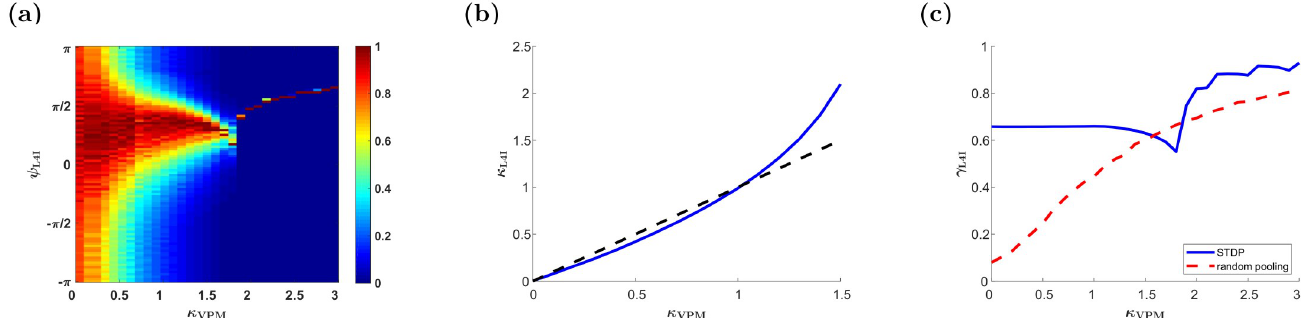
Fig 5. The effect of the distribution width of the upstream population, κ VPM . (a) The (non-normalized) distribution of the preferred phases of L4I neurons, κ L4I , is shown by color as a function of the width of the distribution of preferred phases in VPM, κ VPM . (b) The distribution width in layer 4, κ L4I , is shown as a function of κ VPM (blue). The identity line is shown (dashed black) for comparison. (c) The modulation depth in the downstream population, γ L4I , is shown as a function of κ VPM (blue). For comparison, the modulation depth of the uniform pooling model is also presented (dashed red). The parameters used here are: � n ¼ n = ð 2 p Þ ¼ 7 Hz , κ VPM = 1, γ = 1, D = 10hz, d = 3ms, ϕ 0 = 5 π /6. For the STDP we used the temporally exponential asymmetric kernel, Eq (9), with τ − = 50ms, τ + = 22ms, μ = 0.01, α = 1.1, and λ = 0.01.